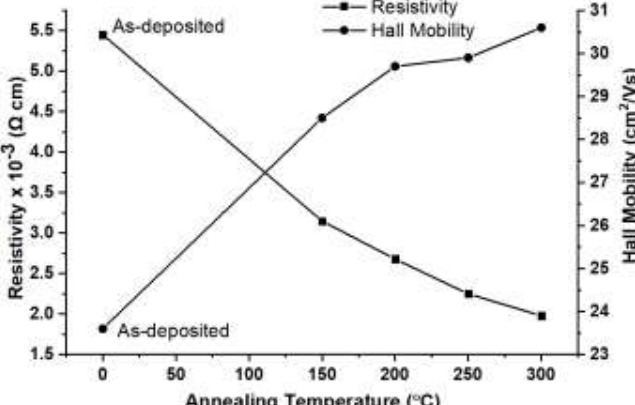
Figure 9: shown the resistivity of the ZnO thin film in the temperature range 150 °C, 200 °C, 250 °C, and 300 °C Table 2. Carrier concentration, resistivity, and mobility of ZnO thin films with variant annealing temperature by OTA